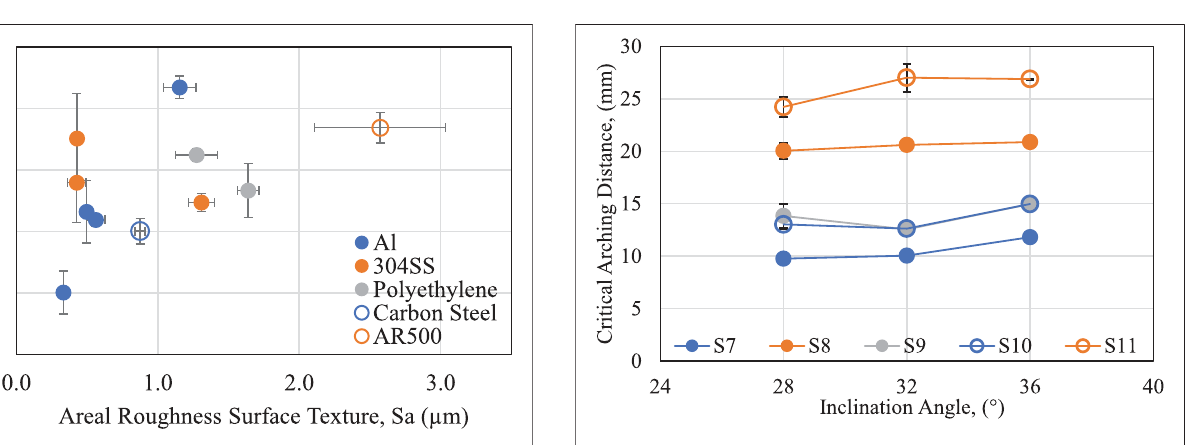
FIGURE 11 | Critical arching distance in a wedge